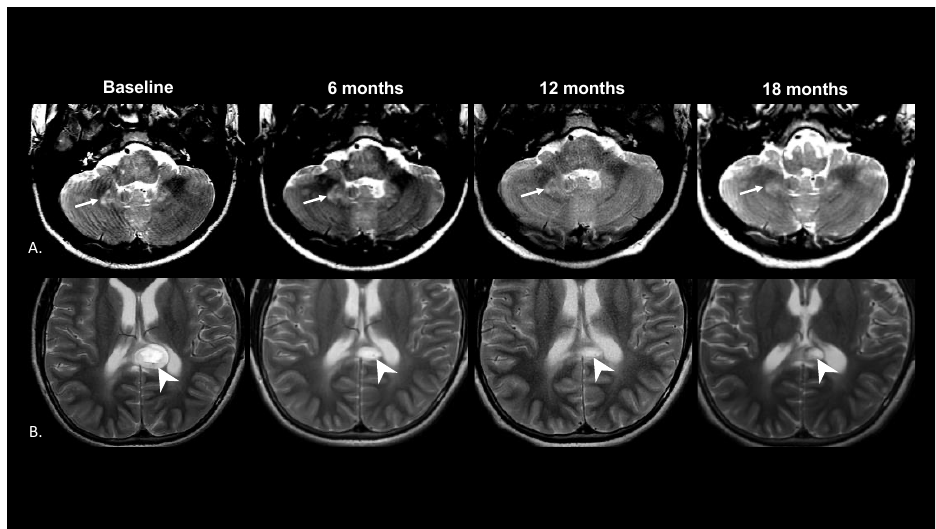
Figure 4. T2 weighted MR imaging of a typical LGG and FASI at four time points during treatment. ( A ) The measured FASI in the right medial cerebellum (arrow) stayed relatively stable during the treatment course. ( B ) The presumed low-grade glioma involving the splenium of the corpus collosum (arrowhead) decreased substantially from the baseline over the treatment course. Table 2. Response criteria at paired time points for FASI with and without treatment and treated LGG.